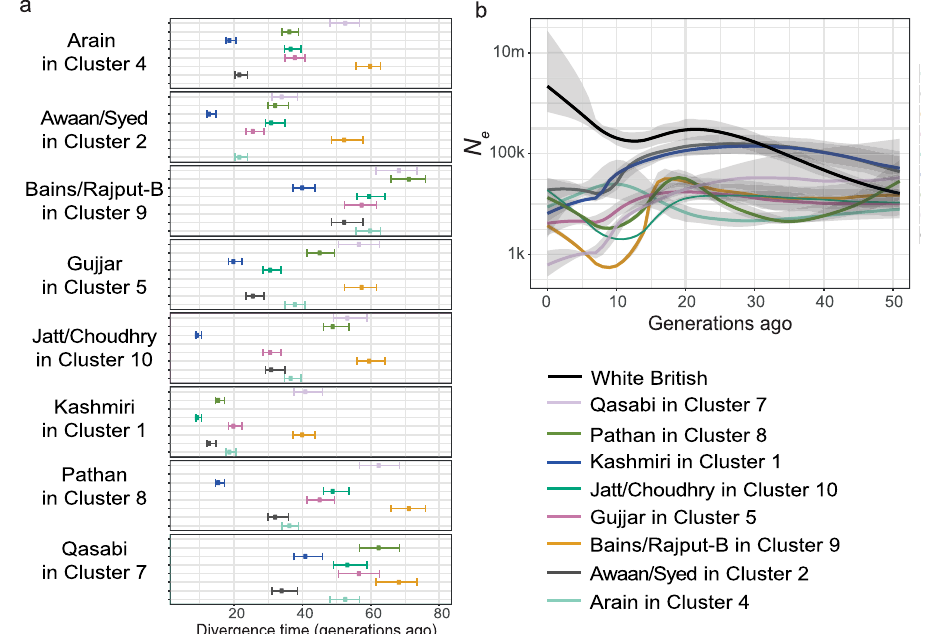
Fig. 3 Divergence times and historical effective population size changes of Bradford Pakistani subgroups. Note that these are the homogeneous subgroups de fi ned using the fi neSTRUCTURE clusters. a Divergence times estimated using NeON 43 ( n = 850 independent individuals). Within each panel, the points show the estimated divergence time between the group indicated on the left on the y -axis and those indicated in the legend. The horizontal lines indicate 95% con fi dence intervals of the estimated divergence time. b Change in effective population size ( N e ) through time estimated with IBDNe. The coloured lines indicate the mean estimate and the grey shading indicates 95% con fi dence intervals of the N e